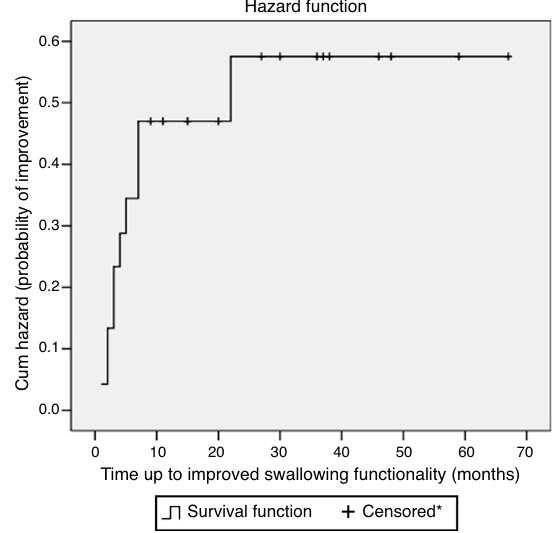
Hazard plot considering the improved swallow- ing according to Functional Oral Intake Scale (FOIS) levels in Parkinson’s disease patients followed at a dysphagia outpatient